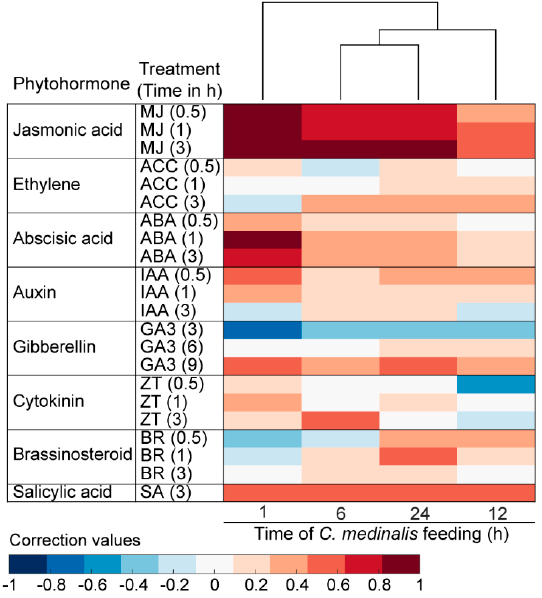
Figure 7. Comparison of plant hormone signatures between transcriptomic data generated after onset of C. medinalis feeding on rice leaves and Arabidopsis response to hormone treatments. Red shading indicates positive and blue shading indicates negative correlations between the rice response to feeding by C. medinalis and the Arabidopsis response to the respective hormone treatments: methyl jasmonate (MJ); 1-aminocyclopropane-1-caroxylic acid (ACC; precursor of ethylene); abscisic acid (ABA); indole-3-acetic acid (IAA); gibberellic acid 3 (GA3); zeatin ZT); brassinosteroid (BR); and salicylic acid (SA).